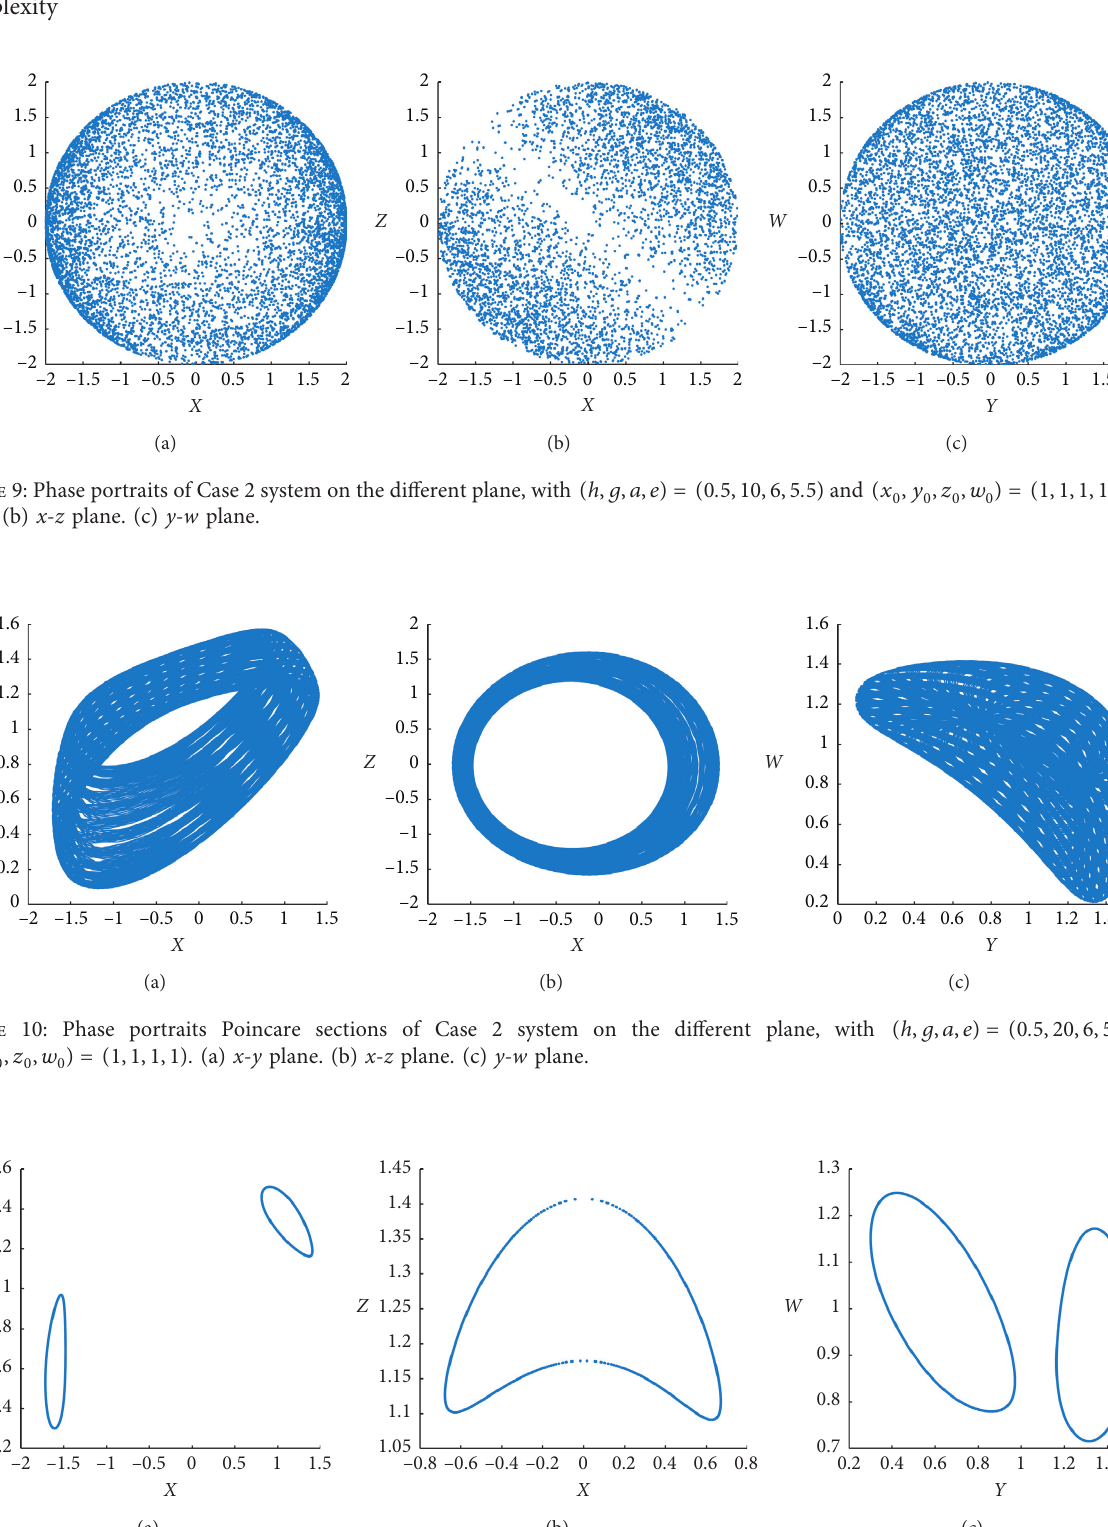
Figure 11: Poincare sections of Case 2 system on the different plane, with ( h, g, a, e ) � (0.5, 20, 6, 5.5) and ( x plane. (b) x-z plane. (c) y-w